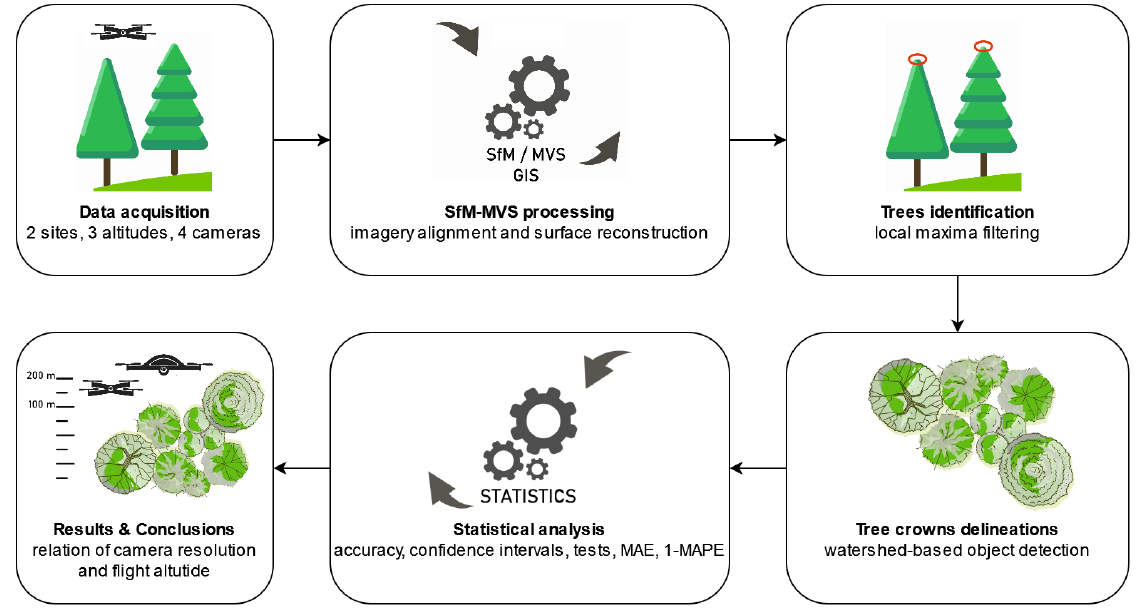
Figure 2. Study processing pipeline. Using four UAVs, data were collected at three different flight levels at two sites. The data were subsequently processed by SfM-MVS methods into the form of orthomosaics and digital surface/terrain models. Then, the treetops were automatically detected and the tree crowns were delineated using the lidR package in R. The accuracy of the automatic methods against the reference data was further evaluated statistically. Table 3. Descriptive statistics of the models’ performance: the accuracy as a percentage of the identified trees (Detected Trees) and the 95% confidence interval (CI 95) for the achieved accuracy; the values of the accuracies of 70% or more (within the range), together with the 95% confidence intervals, are in bold. In total, 612 detected trees were used for reference at each